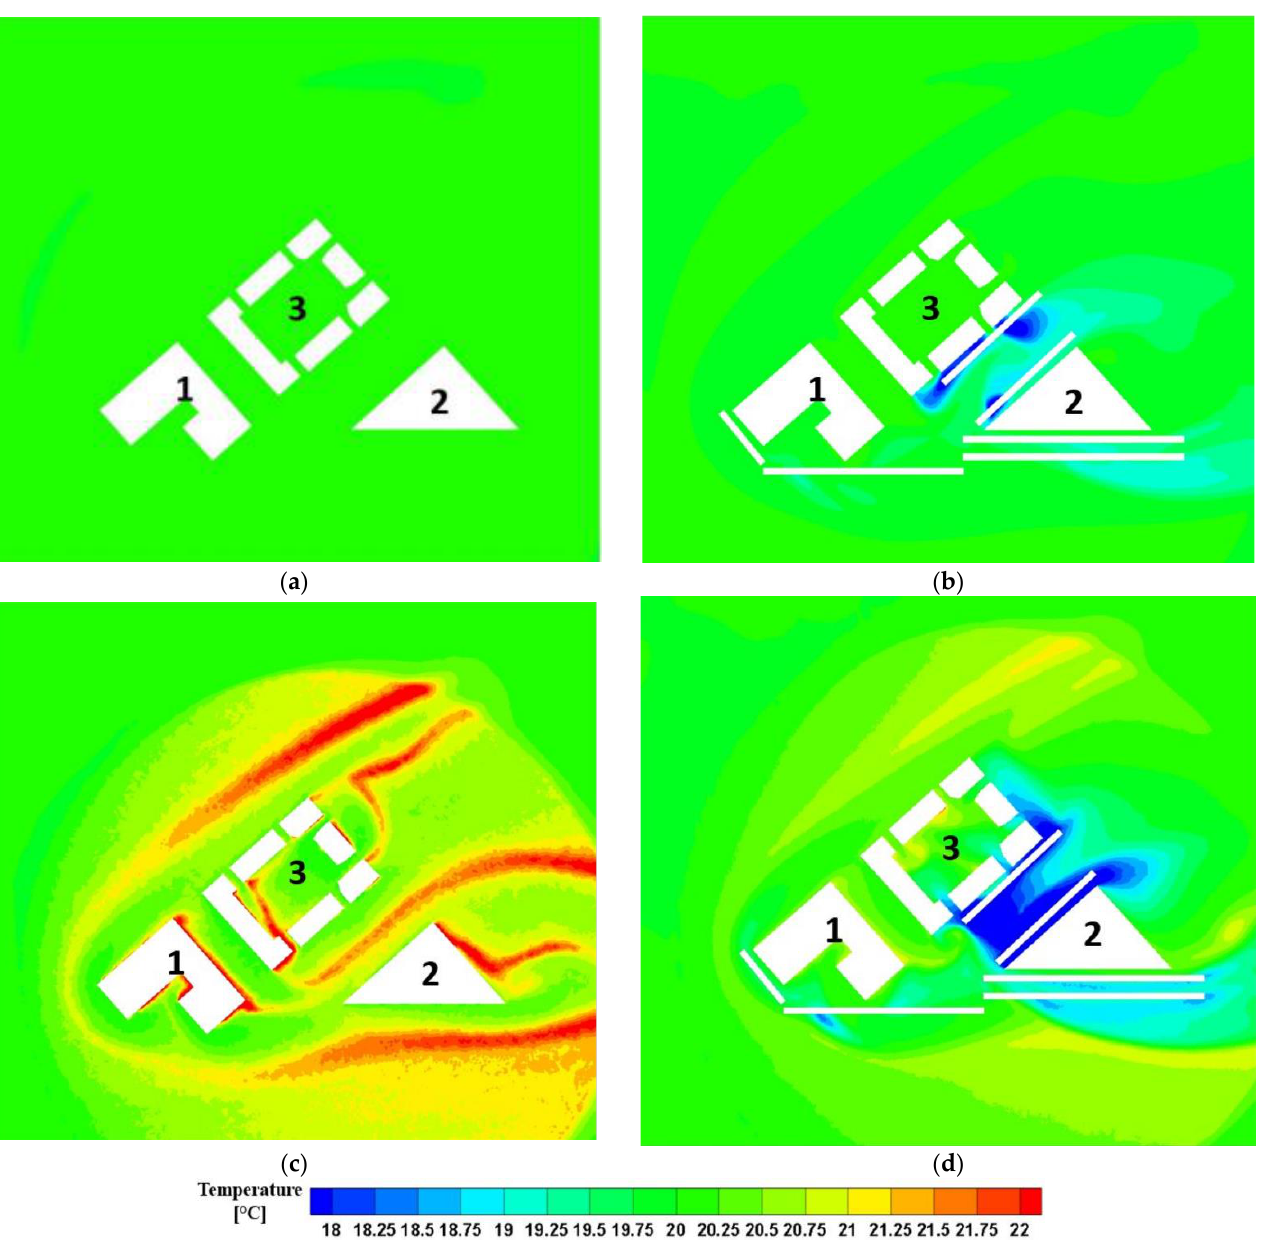
Figure 6. Contours of temperature at the pedestrian level [55]. ( a ) Scenario 1 without vegetation. ( b ) Scenario 1 with trees. ( c ) Scenario 5 without vegetation. ( d ) Scenario 5 with trees.